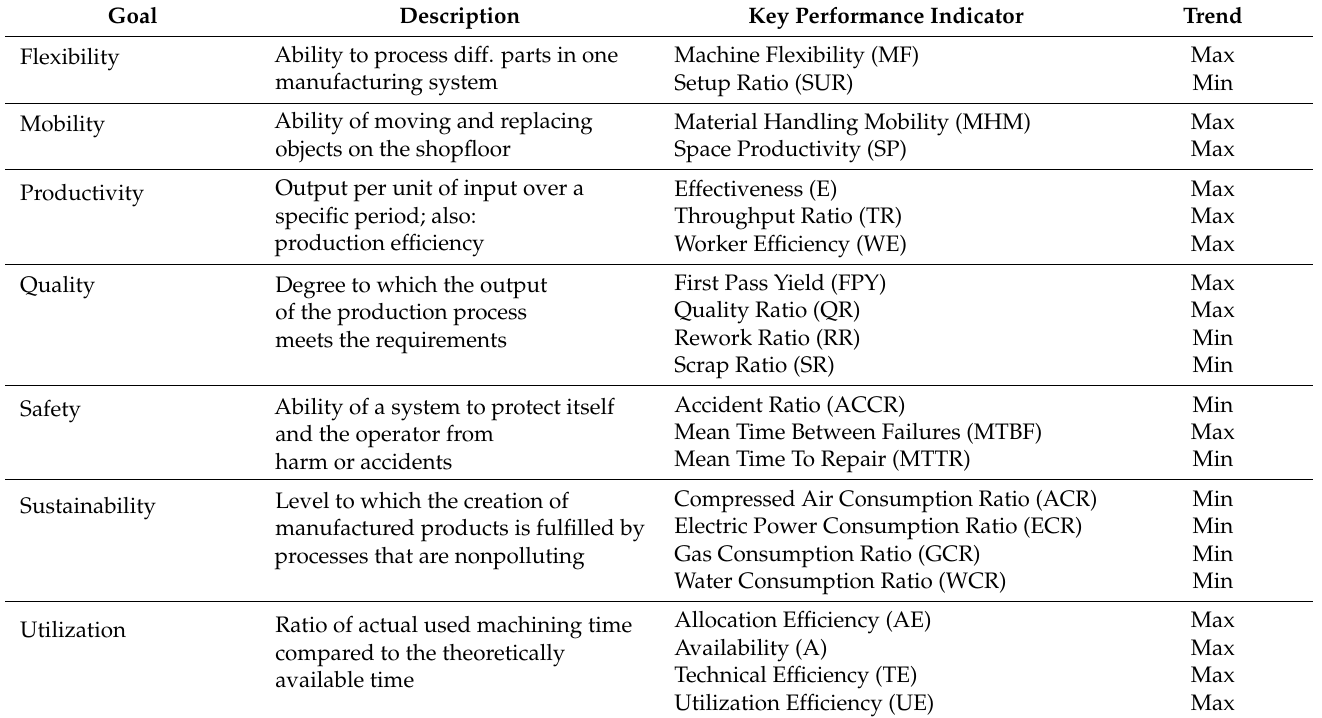
Table 1. Technical goals when implementing 5G technology in production